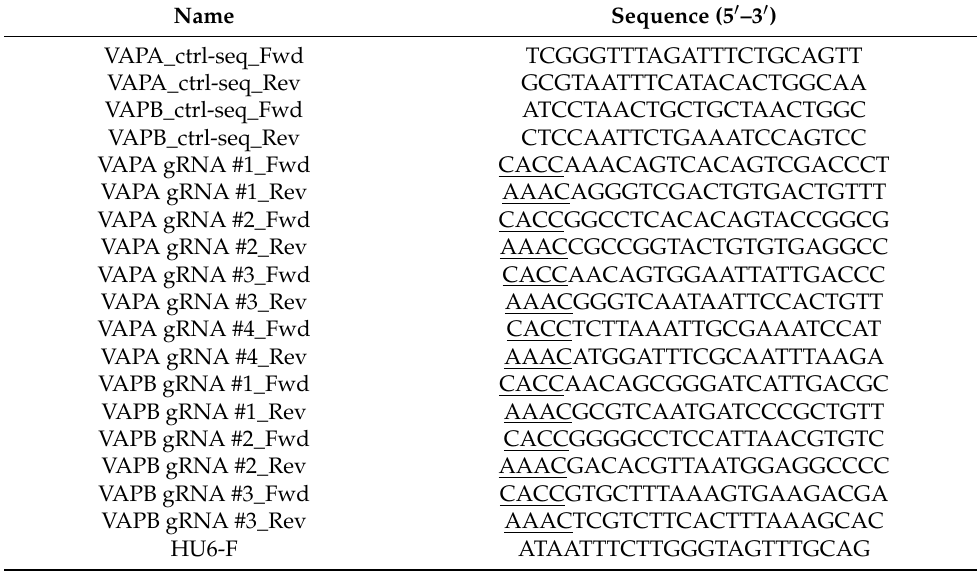
Table 1. Primer and oligonucleotide sequences. Compatible 5 (cid:48) overhangs for restriction enzyme BbsI used for cloning are